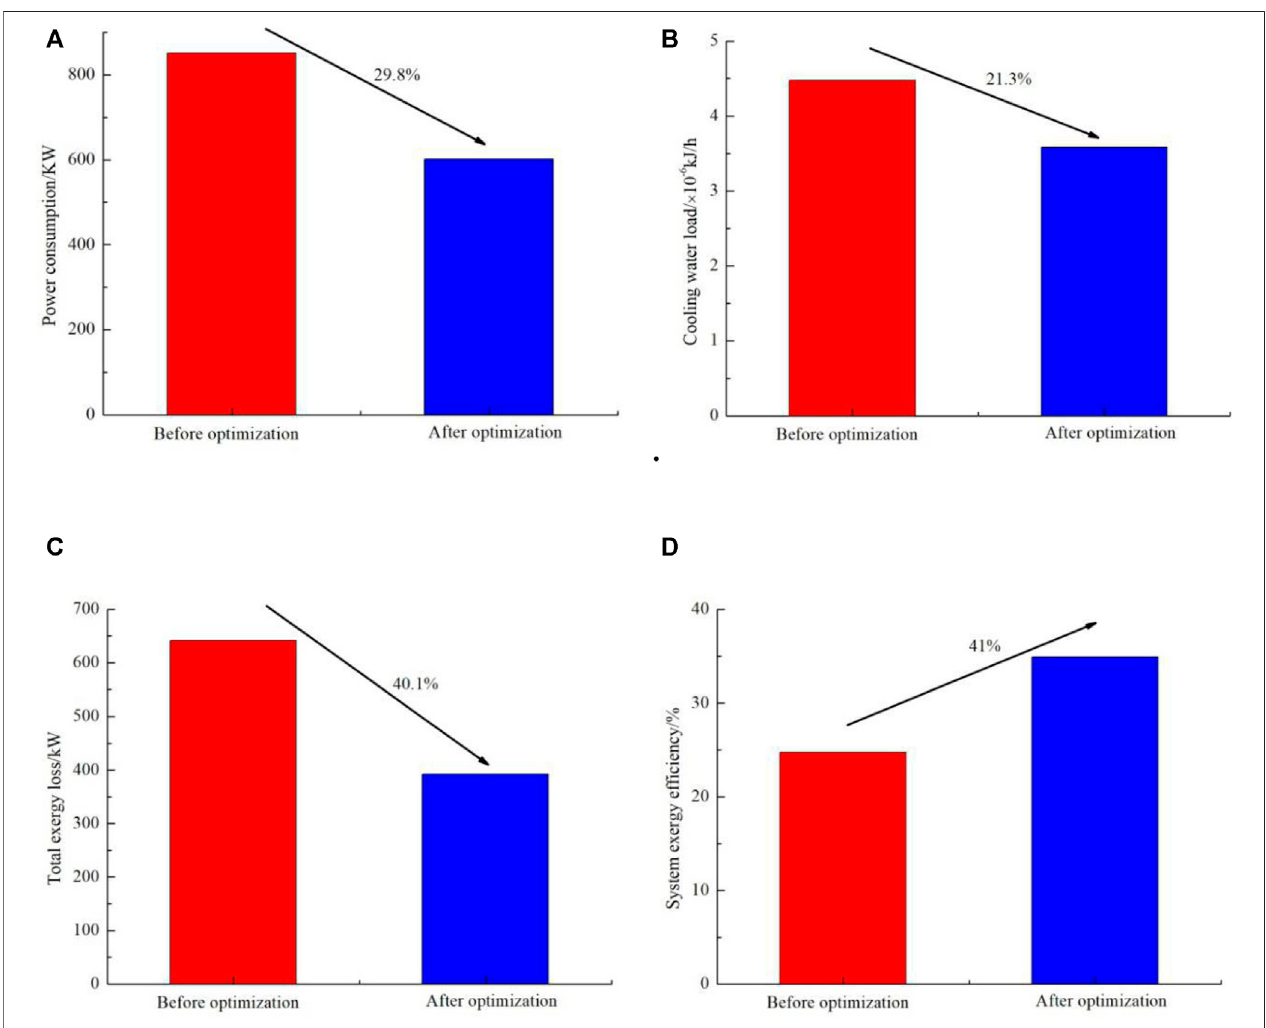
FIGURE 4 | Comparison of liquefaction performance: (A) Power consumption, (B) Cooling water load, (C) Total exergy loss, (D) System exergy ef fi ciency.